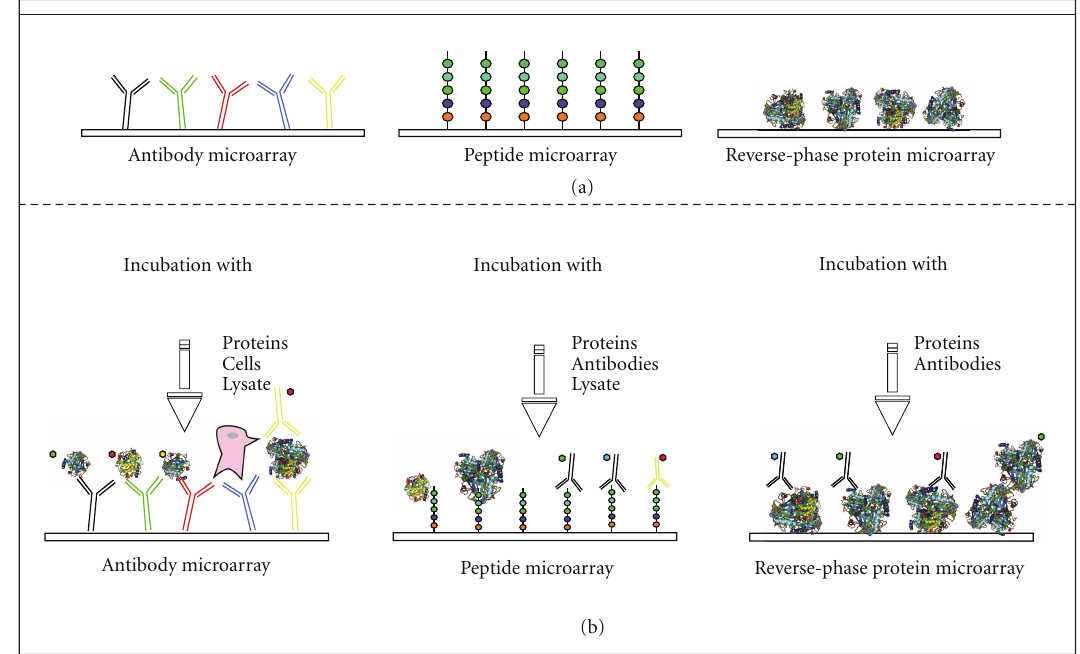
Figure 1: Modified from Hultschig et al. 2006 [7]. Di ff erent types of protein microarrays with their di ff erent substrates and detection methods. (a) After immobilization and (b) after incubation with di ff erent